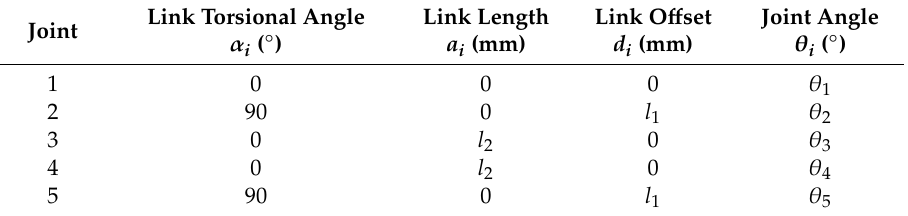
Table 1. Denavit–Hartenberg (D–H) parameters of the climbing